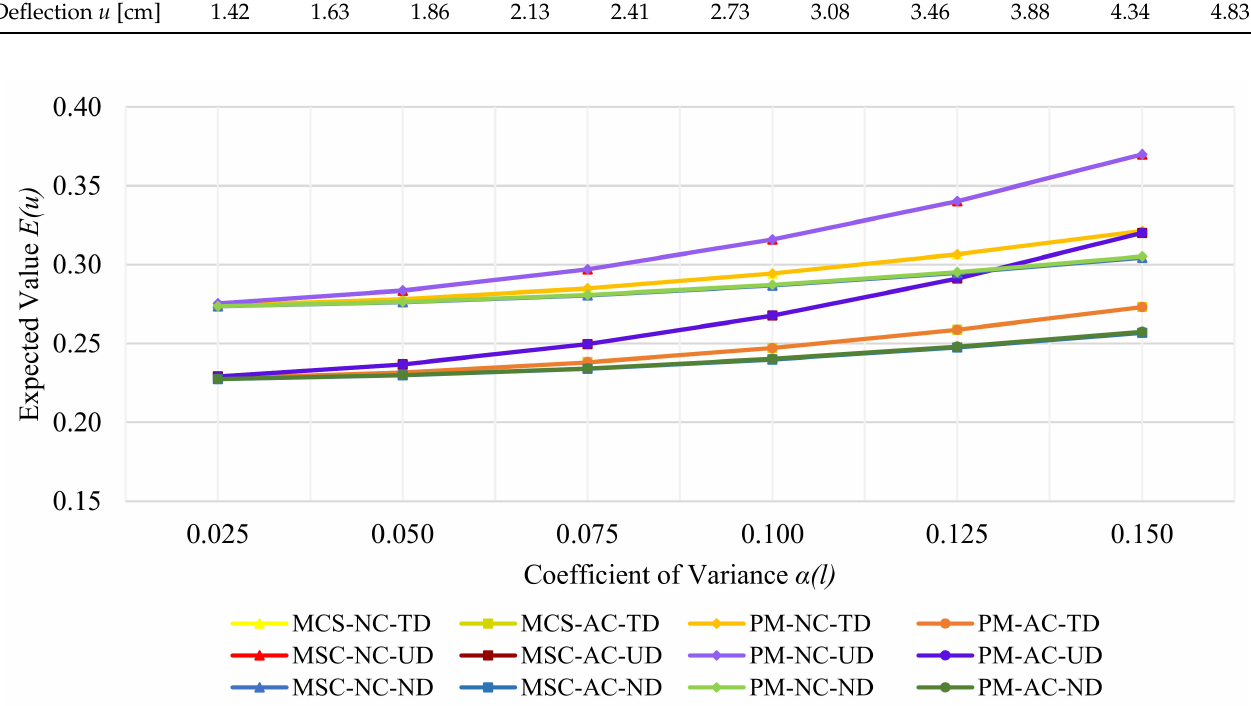
Figure 6. Expected value E [ u ] in the